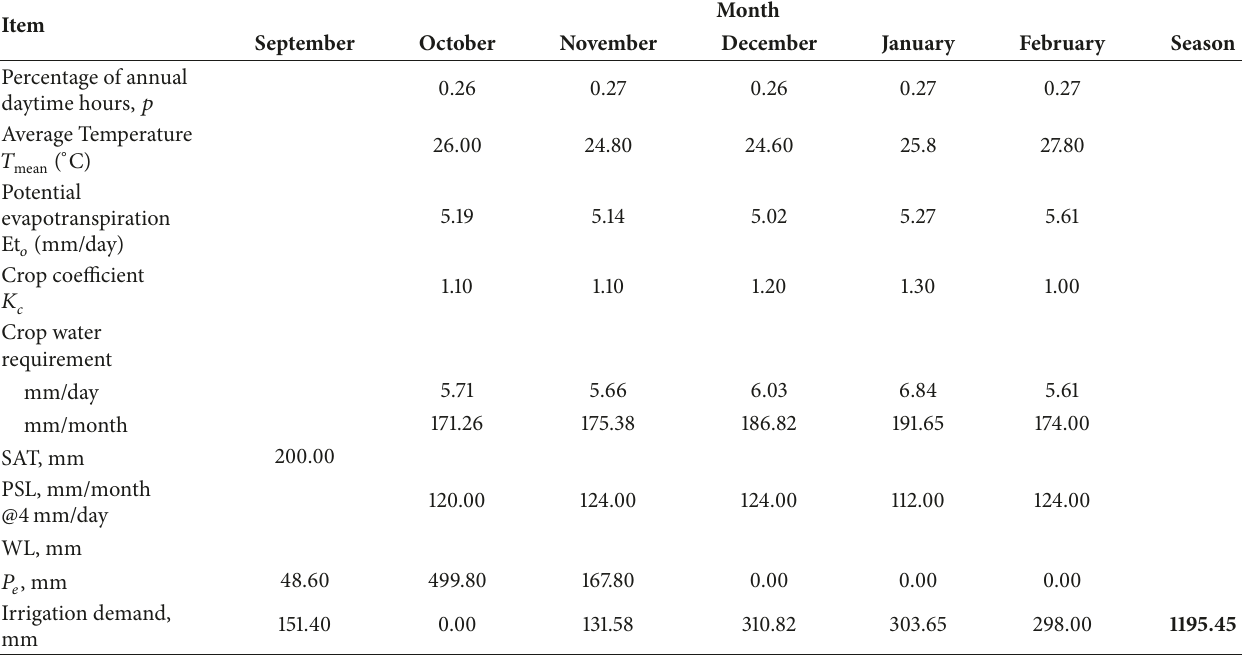
Table 5: Computation of irrigation demand for paddy for the year